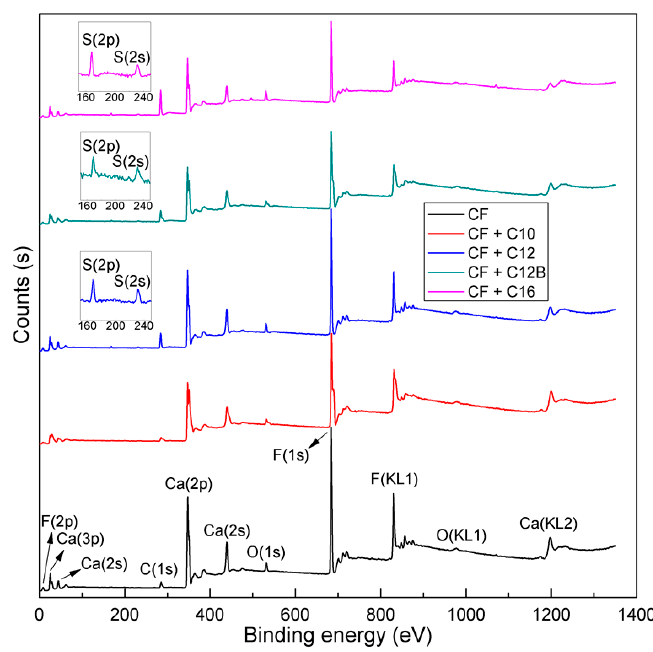
Figure 7. Full-scan XPS spectra of fluorites with and without pretreatment of sulfonate-based collectors.